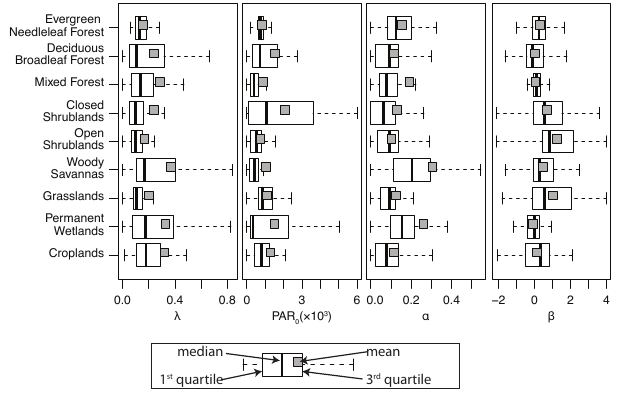
Fig. 3. Box-and-whisker plots for values of VPRM parame- ters, estimated monthly by plant functional type (PFT). Whiskers show 1.5 times the interquartile range. Units for parame- ters are as follows: λ : µmol CO 2 m − 2 s − 1 /µmol PARm − 2 s − 1 ; α : µmol CO 2 m − 2 s − 1 ◦ C − 1 ; β : µmol CO 2 m − 2 s − 1 ; PAR 0